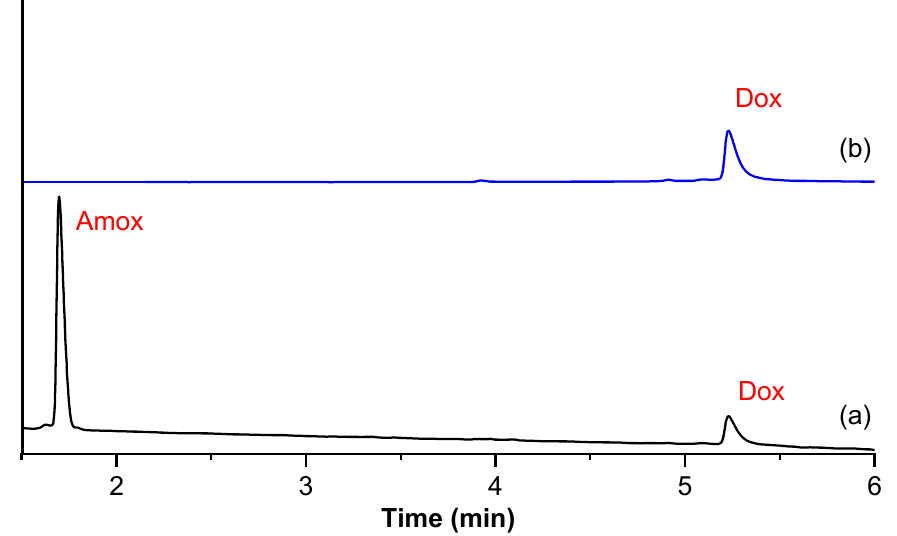
Figure 2. HPLC chromatograms of Amox and Dox recorded at two different wavelengths: ( a ) 350 nm and ( b ) 230 nm, at 100 μ g/mL.